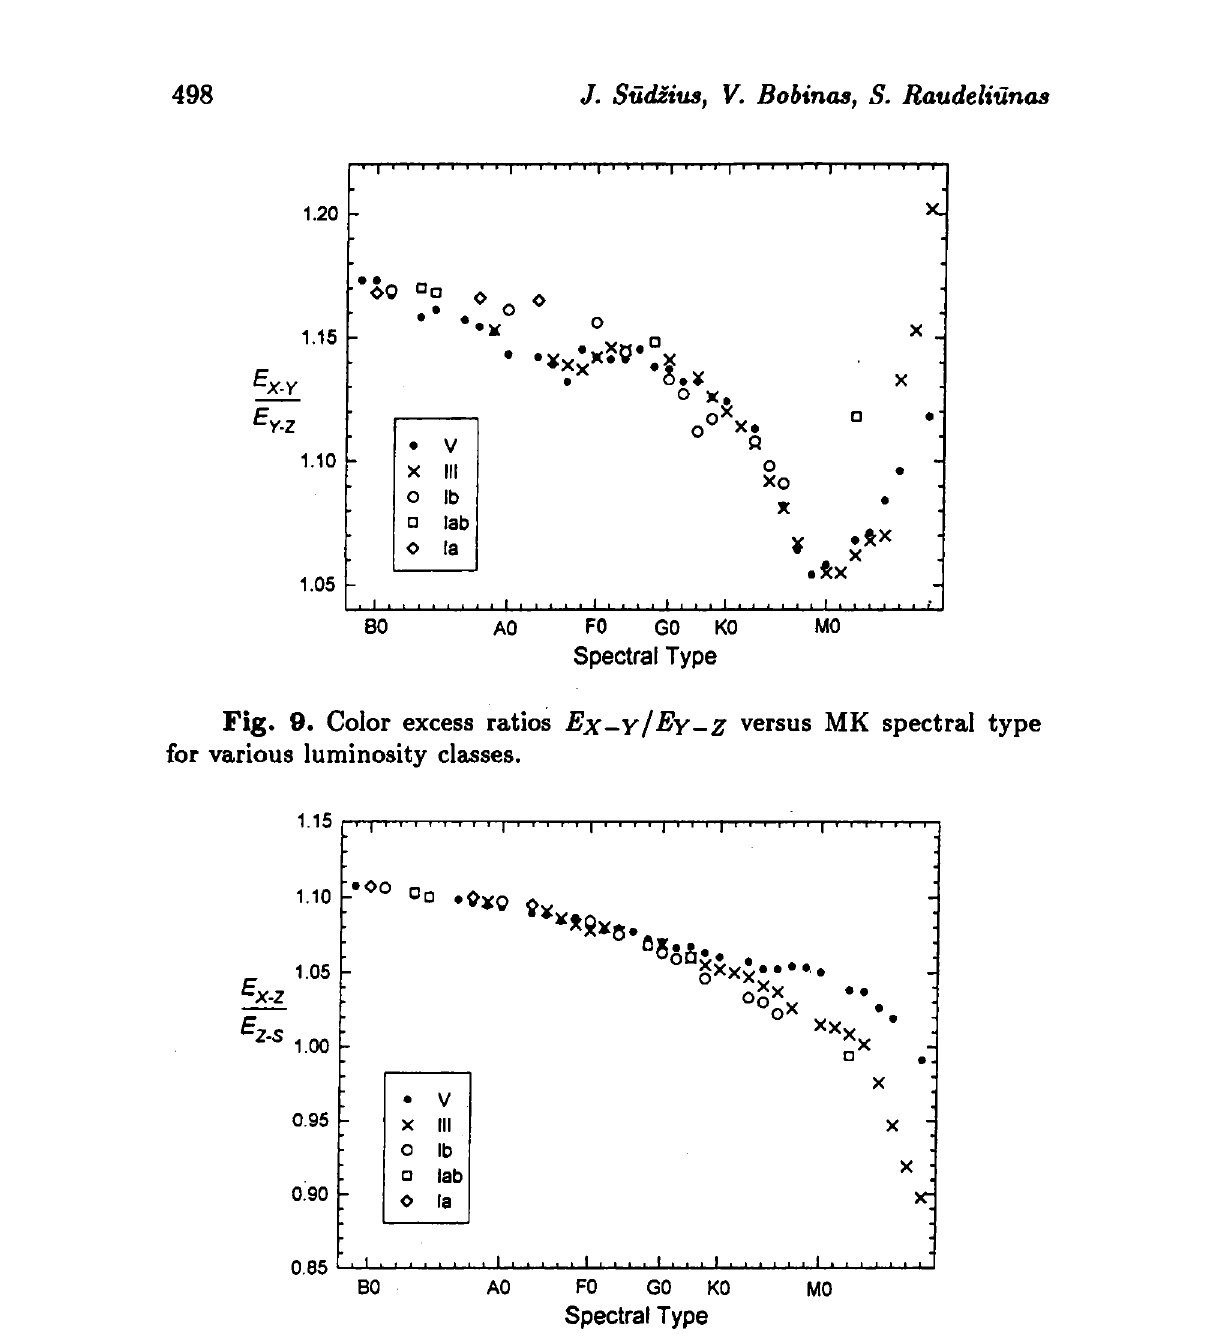
Fig. 10. Color excess ratios Ε χ - ζ ΐ Ε ζ -s versus MK spectral type for various luminosity